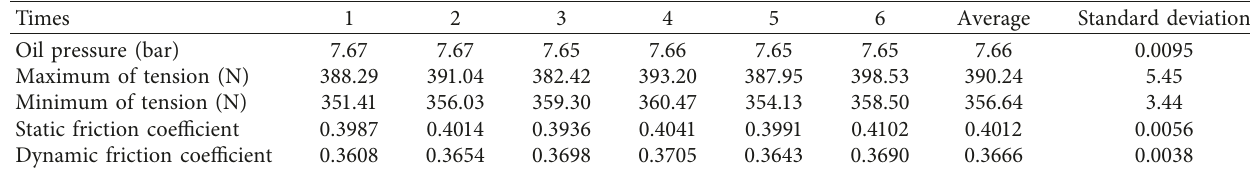
Table 1: Friction coefficient under 8bar oil pressure.